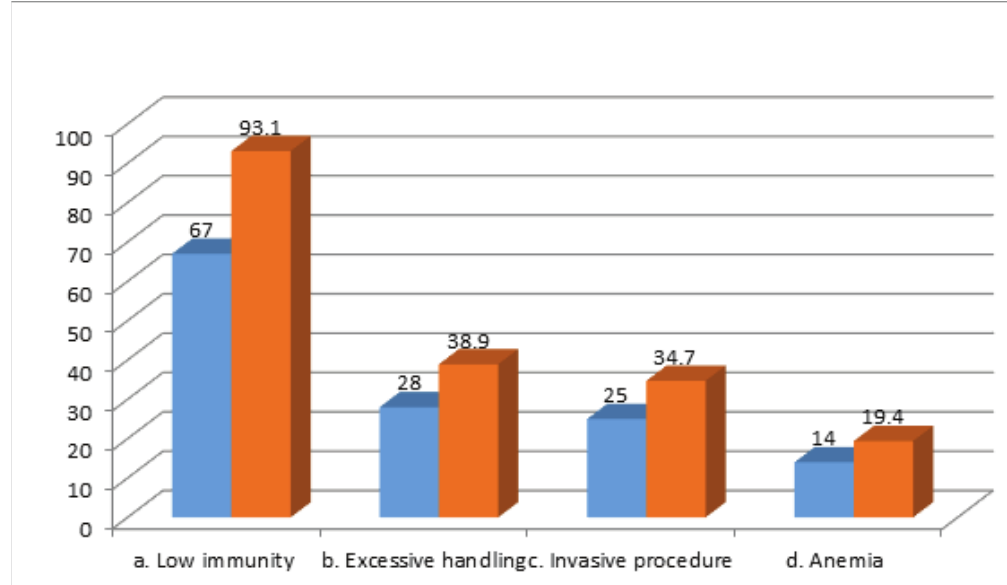
Figure 2: Distribution of the study samples according to their knowledge regarding the susceptibility of preterm infant to